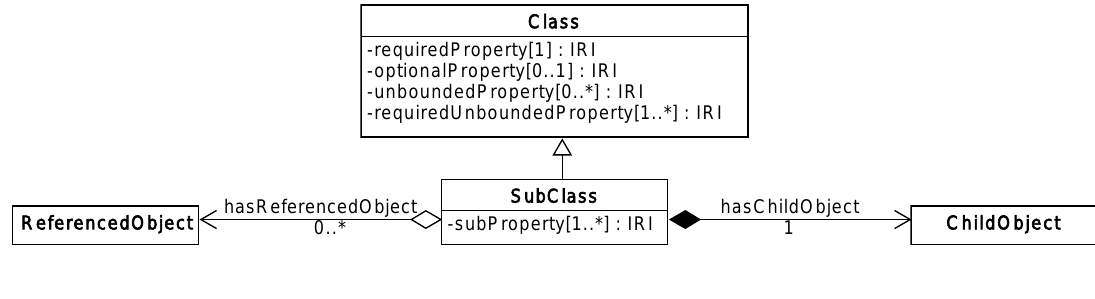
Figure 4: Examples of UML diagram conventions used in this